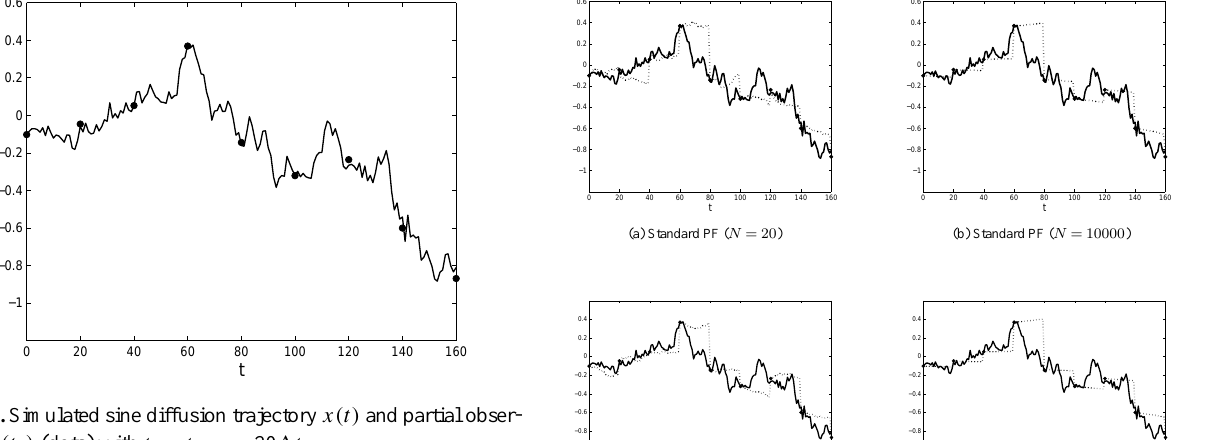
Figure 1. Simulated sine diffusion trajectory x(t) and partial obser- Fig. 1: Simulated sine diffusion trajectory x ( t ) and partial observations y ( t k ) (dots) with t k − t k − 1 = 20∆ t . vations y(t k ) (dots) with t k − t k − 1 = 20 1t .